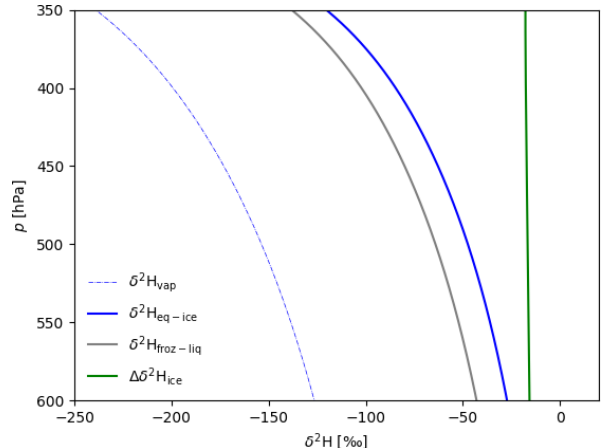
Figure A3. Expected (cid:49)δ 2 H ice (green line) when assuming a typical moist adiabatic profile of upper-tropospheric δ 2 H vap (dashed thin blue line) with T 0 = 30 ◦ C at 1000hPa. The equilibrium ice formed from this vapour is shown by the thick blue line, and the ice formed from the freezing of locally condensed vapour is shown by the thick grey